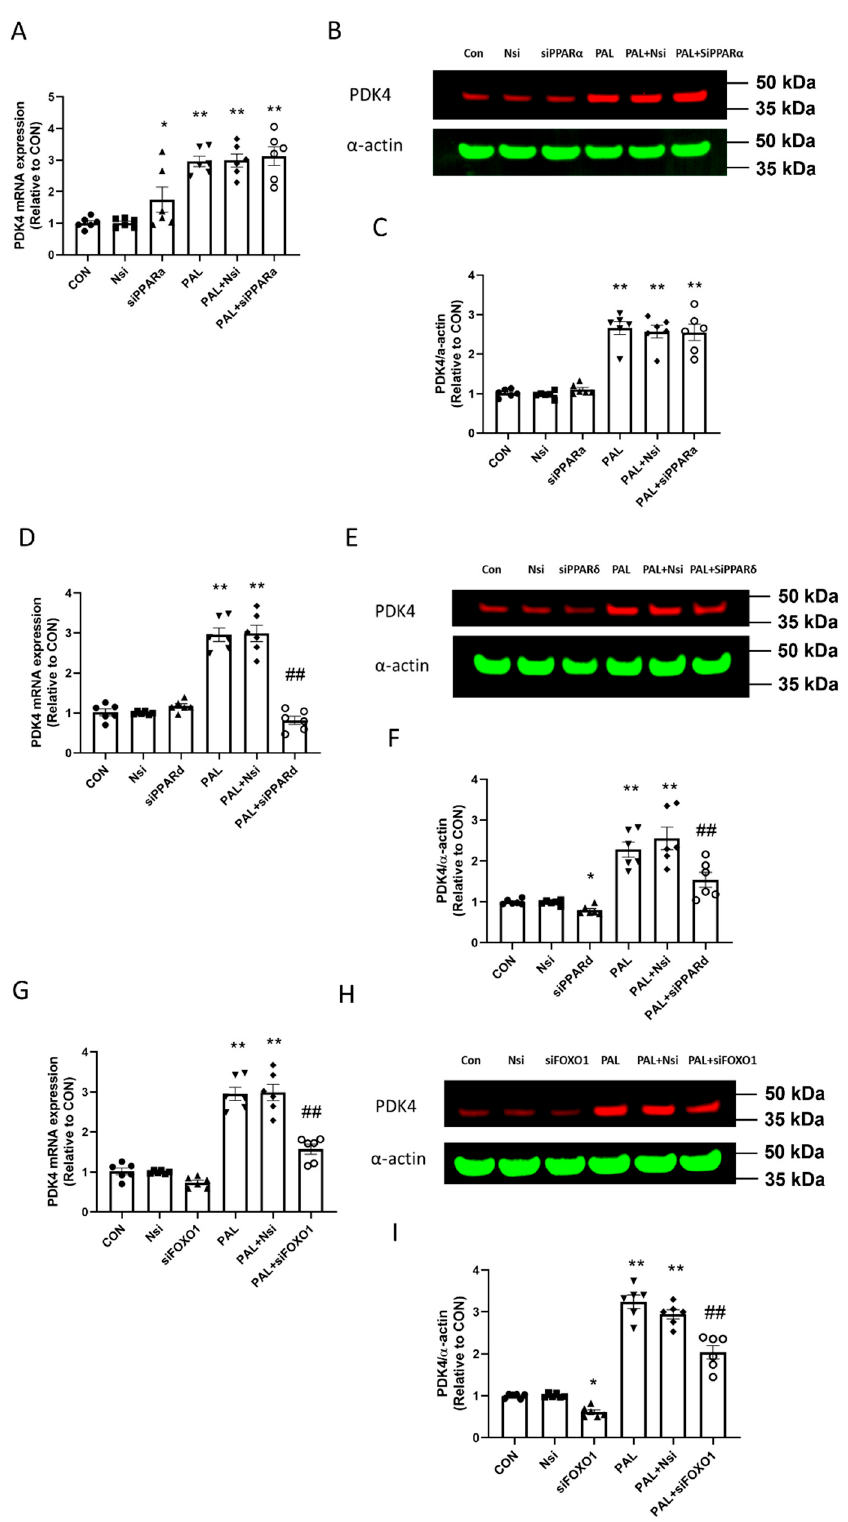
Figure 5. PDK4 gene ( A , D , G ) and protein expression ( B , C , E , F , H , I ) in C2C12 myotubes after individ- ual PPAR α , PPAR δ and FOXO1 siRNA gene silencing in the absence ( left panels ) or the presence of palmitate (PAL; right panels ). Significantly different from control without PAL (CON, * p < 0.05, ** p < 0.01). Significantly different from CON + PAL ( ## p < 0.01). Data represent mean ± SEM of 6 individual experiments for each intervention group. Nsi—silencer negative control.